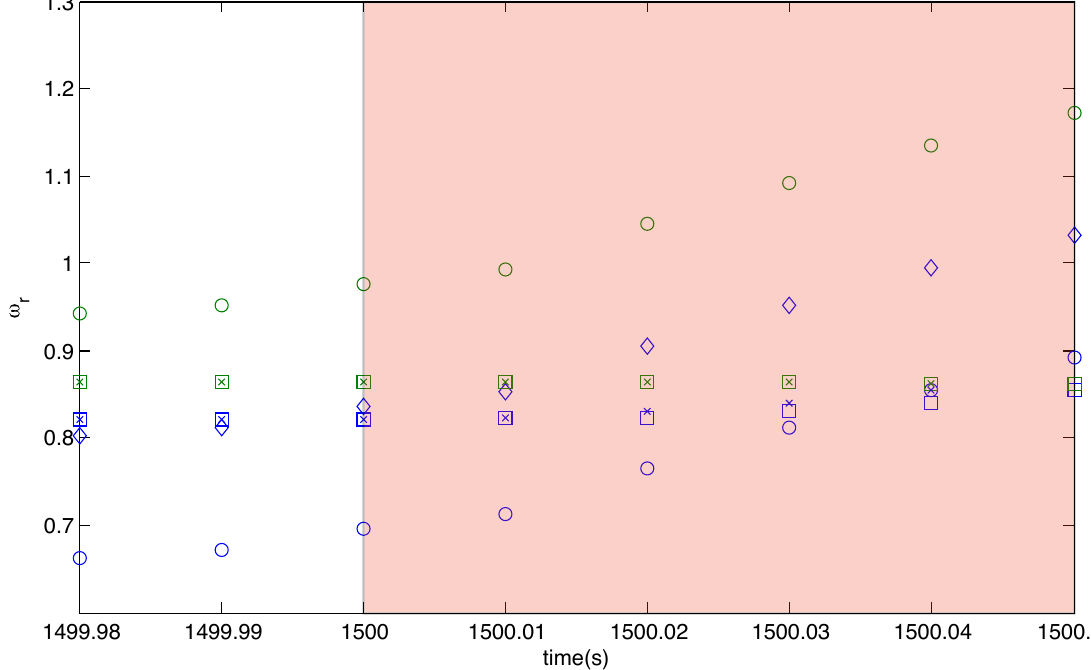
Figure 7. Detection of fault 4, (cid:5) : current measurement ω (cid:3) : [ ω ( k )] p , × : [ ω ( k )] c . 5 samples after the occurrence of the fault, [ ω r , m 1 r , m 1 [ ω ( k )] y do not intersect, which means [ ω r , m 1